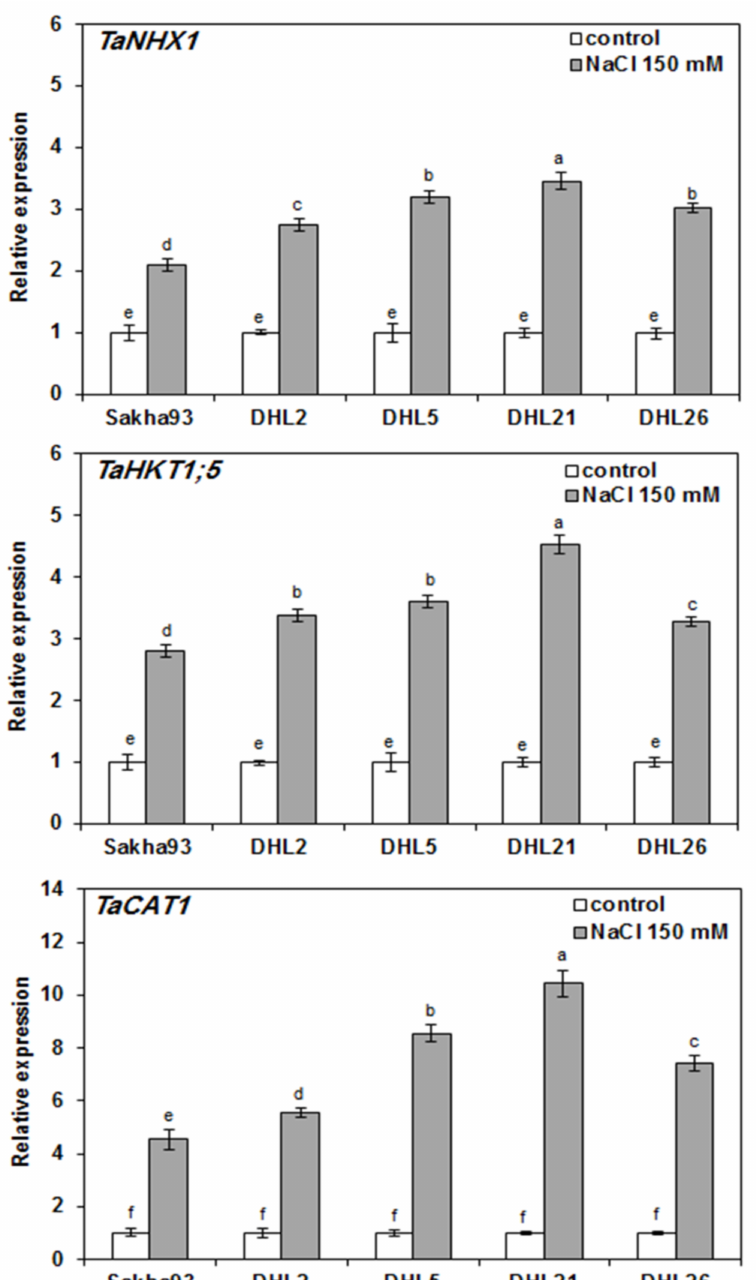
Figure 10. Gene expression profiles of three salt-stress-related genes in leaves of five wheat genotypes subjected to irrigation water with or without 150 mM NaCl. Values are presented as the mean ± SE of at least three replications, and values sharing the same letter for each treatment × genotype combination are not significantly different ( p ≤ 0.05) according to Duncan’s multiple range